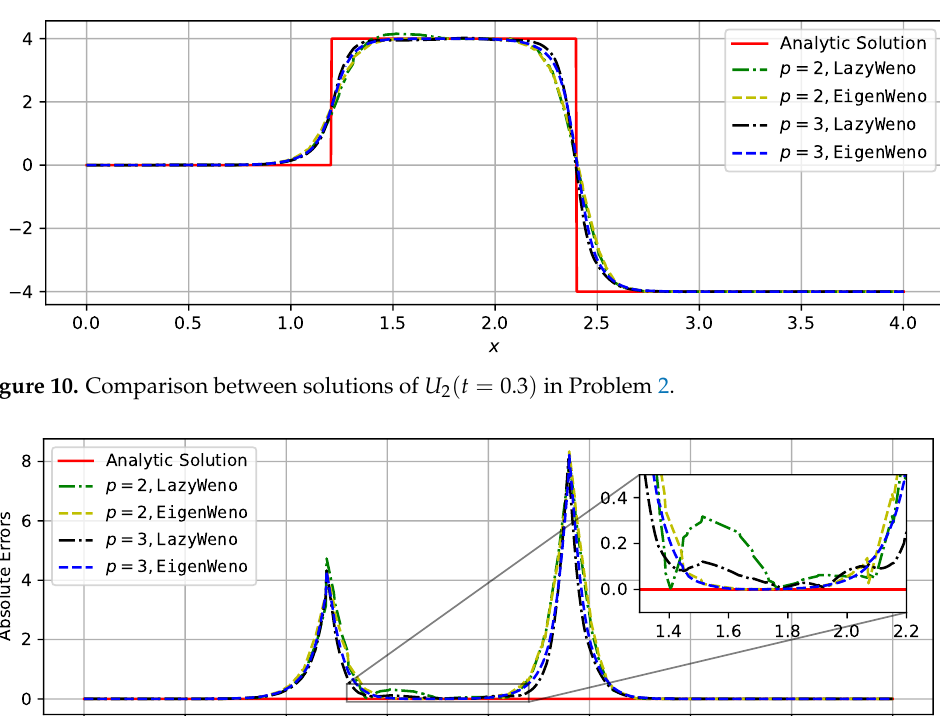
Figure 9. Comparison between solutions of U 1 ( t = 0.3 ) in Problem 2.